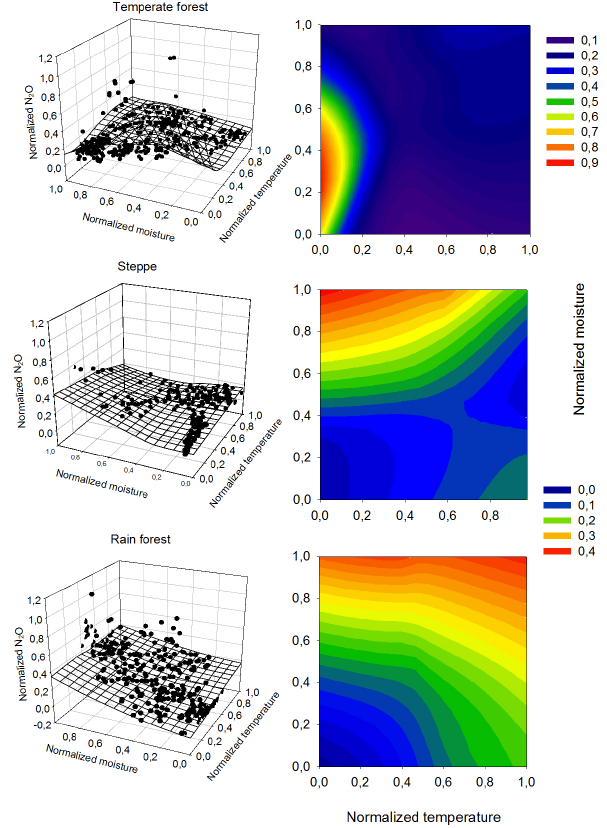
Fig. 6. Temperature and moisture effects on soil nitrous oxide fluxes for the three different ecosystems (temperate forest, semi- arid steppe, and tropical rain forest). Freeze and thaw periods were included. For this analysis nitrous oxide fluxes, soil temperature, and moisture data were normalized at site scale to a range of 0–1 (0: lowest observed value; 1: highest observed value). Nitrous oxide data for H¨oglwald Forest were randomly selected from observations in the years 1995 and 1997. Prior to the calculation of contour lines, data were smoothed with the loess algorithm or negative exponen- tial algorithm (sampling proportion